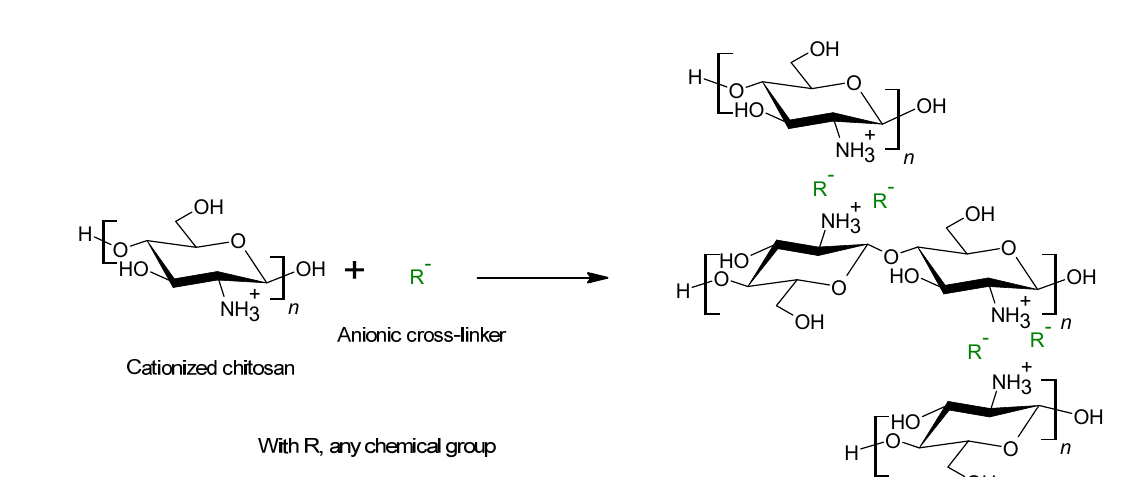
Figure 5. Ionic cross-linking reaction between chitosan and a negatively charged cross-linker .